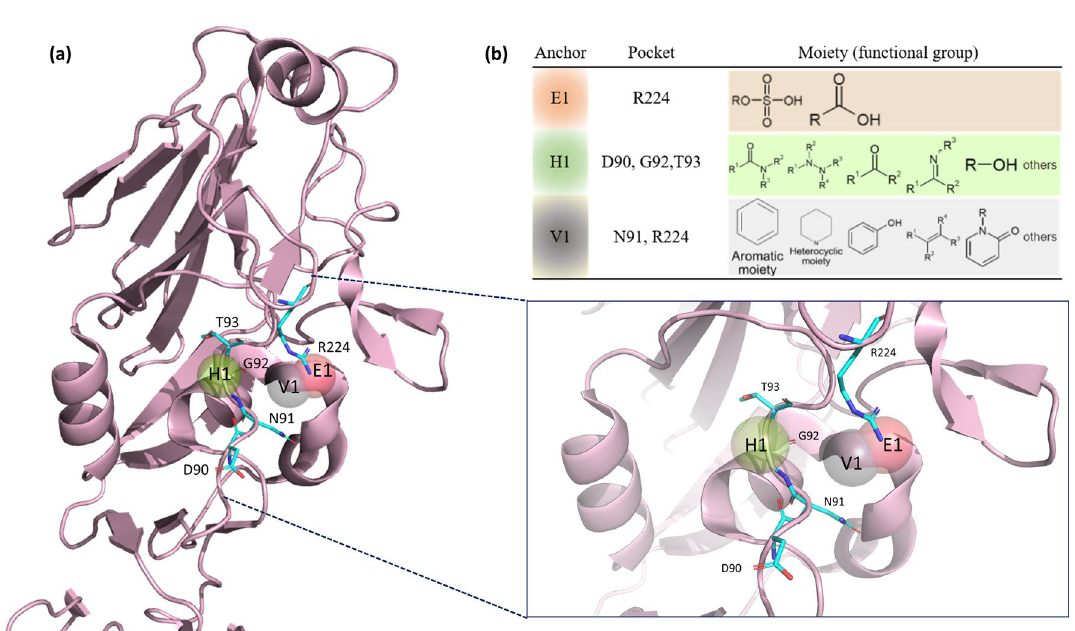
Figure 2. Receptor-binding site anchors obtained from SiMMap. (a) The RBS structure of the H1N1 HA (chain H of 1RUY) is depicted as a cartoon and three anchors as transparent spheres. Red E1 stands for the electrostatic force, green H1 for hydrogen bond force, and grey V1 for van der Waals forces. The corresponding binding pockets (residues) are shown in the cyan sticks. (b) The table presents binding pockets and moieties for each anchor. Each moiety of the anchor represents the functional group preference of the top-ranked